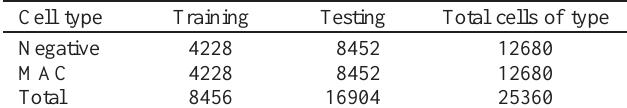
Table 1 The breakdown of the number of cells of each type used to train